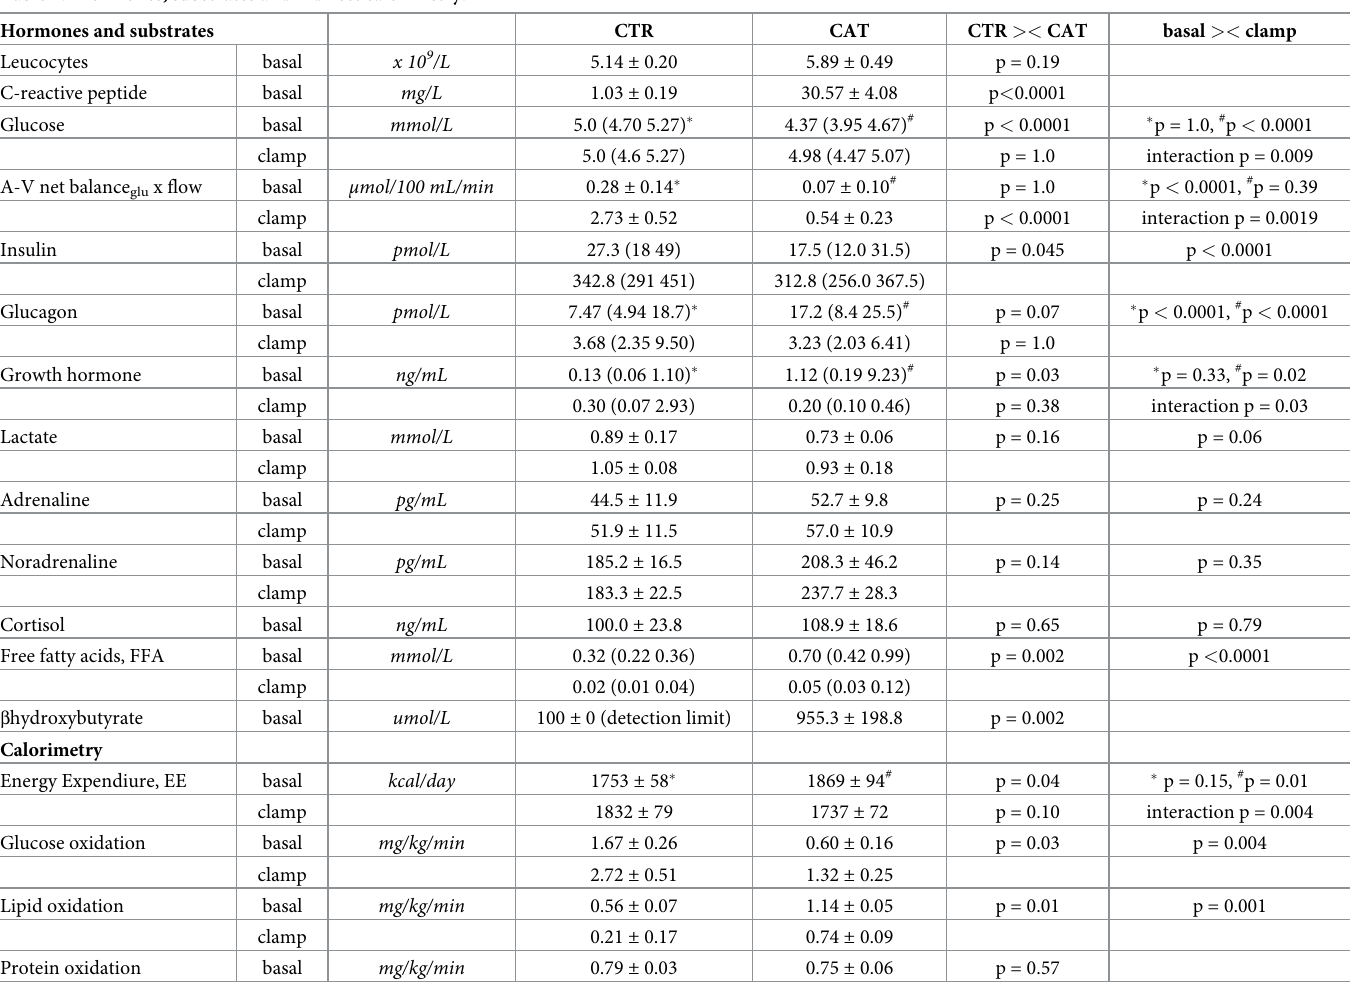
Table 2. Hormones, substrates and indirect